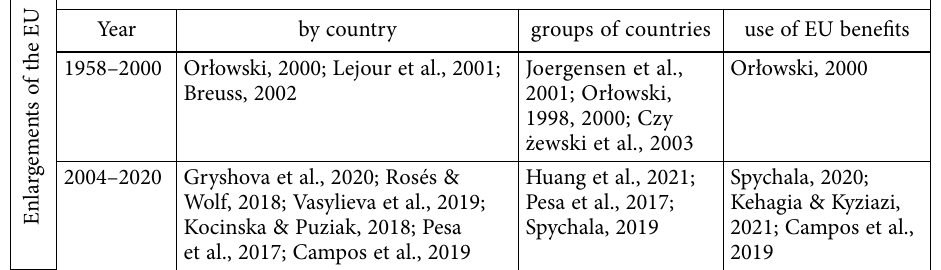
Table 1. Structural analysis of the convergence of economic development in EU countries (source: compiled by the